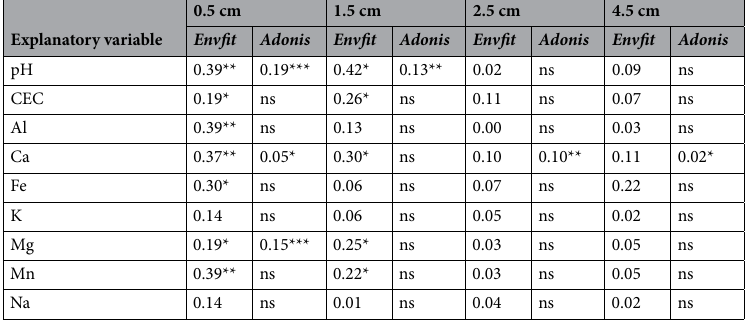
Table 2. R2-values of Envfit and Adonis (PERMANOVA) analyses. The Envfit analysis test for significant correlation of environmental parameters to the NMDS projections of community dissimilarities between samples (Bray–Curtis) each parameter separately. The Adonis analysis test whether environmental parameters significantly explain the observed community dissimilarities (Bray–Curtis) between samples and uses a statistical model that includes all environmental parameters. Values are R2-values. Asterisks refers to significance level (* is 0.01 < p < 0.05, ** is 0.001 < p < 0.01, *** is p < 0.001). “ns” are non-significant results from the Adonis